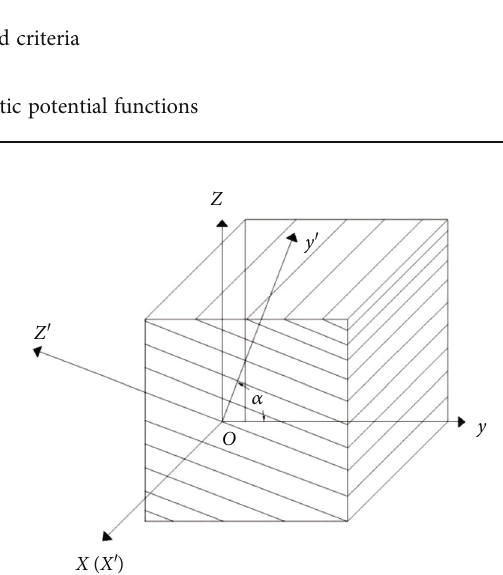
Figure 1: Relationship between local and global coordinate